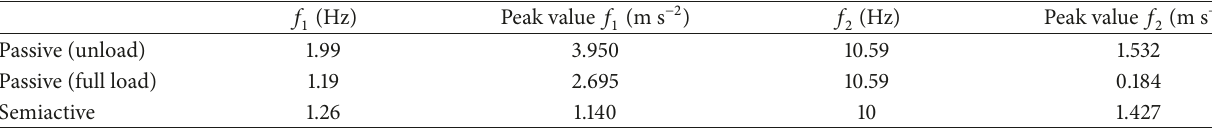
Table 3: Natural frequencies and RMS values of BA.